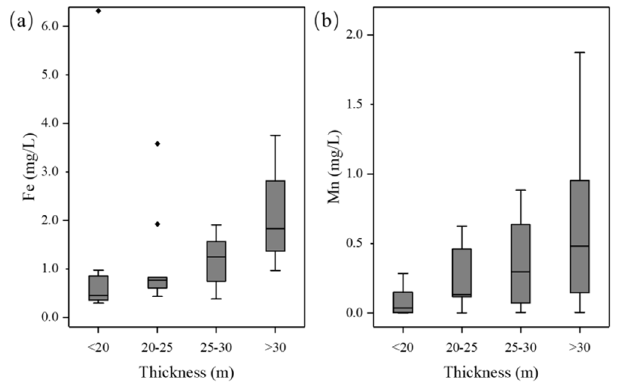
Figure 3. Boxplot of sample well clay thickness and Fe ( a ) and Mn ( b ) content (on the platform).